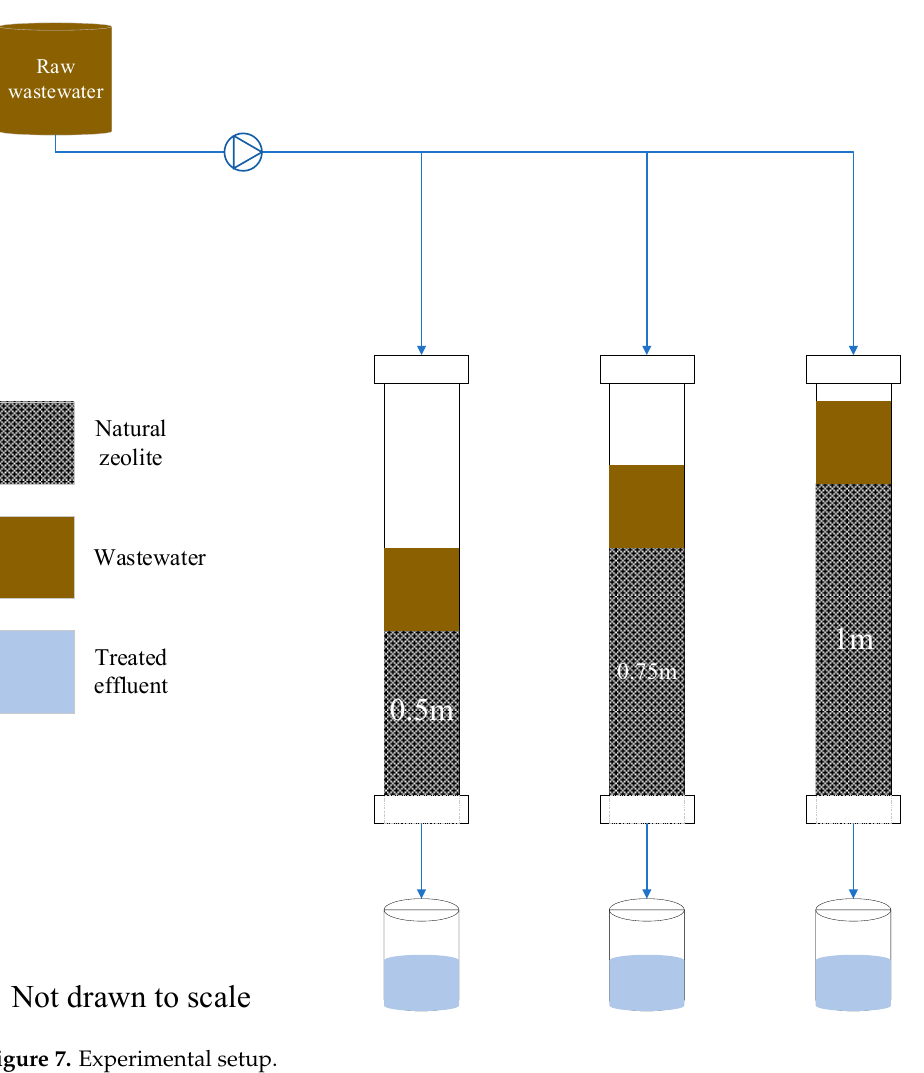
Figure 7. Experimental setup.